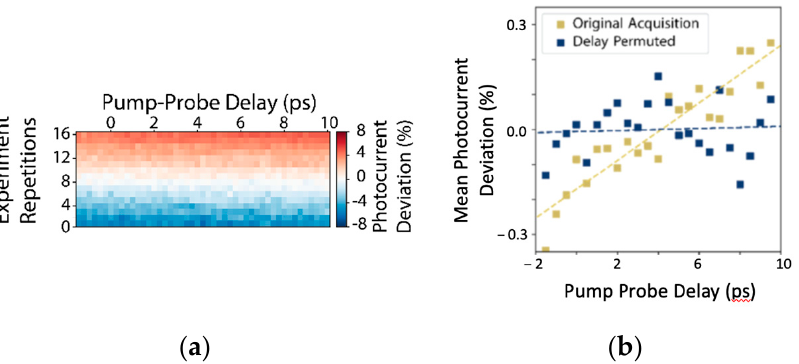
Figure 4. Using analysis-in-the-loop to improve experimental reliability. ( a , b ) Scan primitives provide options to reduce systematic bias in time-resolved angle-resolved photoemission spectroscopy experiments. ( a ) laser power fluctuations over a Tr-ARPES experiment acquired by traversing delay and repetitions in major delay order. ( b ) Systematic bias due to small laser power variations throughout the experiment (yellow dots and trend), which are removed by acquiring data in random order (simulated with identical variability, blue